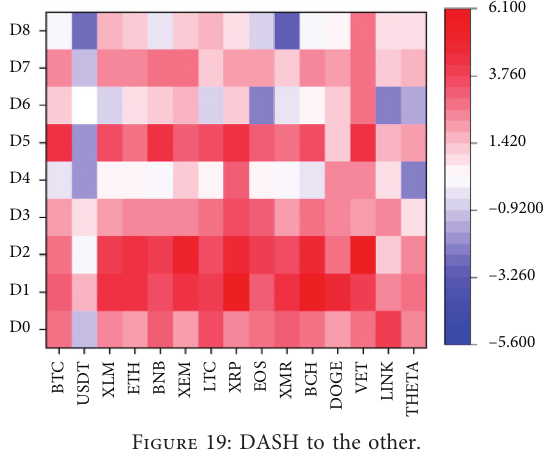
Figure 22: DOGE to the other.